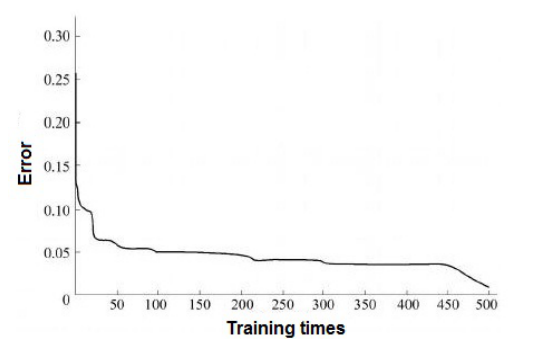
Figure 2. Error and training times of ANN